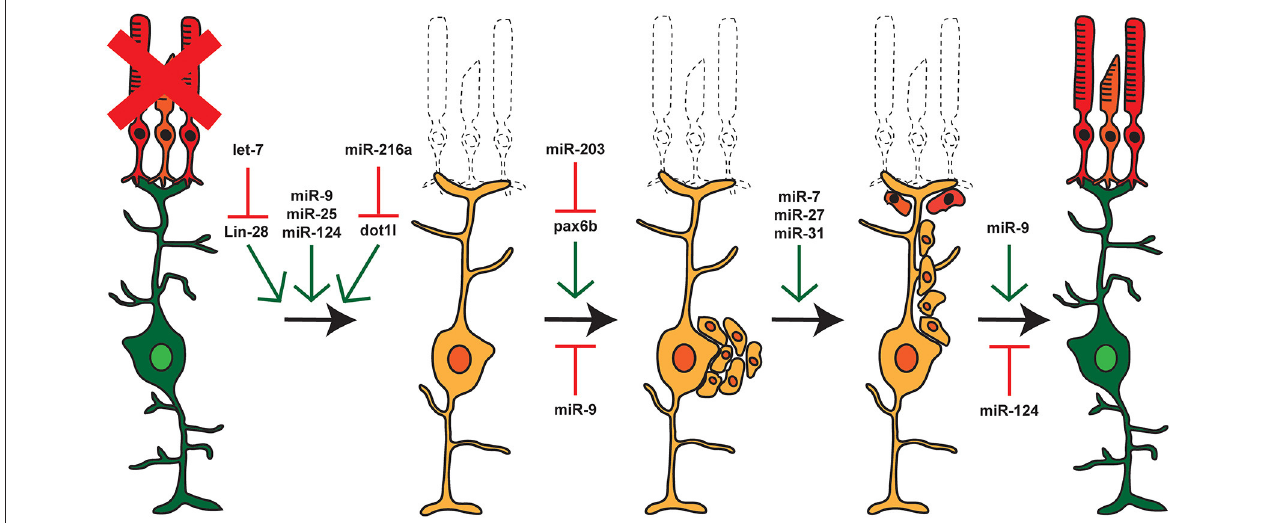
FIGURE 3 | miRNAs and Retina Regeneration. The adult zebrafish retina expresses ∼ 200 miRNAs but only a small subset of these miRNAs are differentially expressed during regeneration. RNAseq and other analyses after damage or during distinct stages of regeneration have identified miRNAs and select target mRNAs, as indicated. Green arrows represent miRNAs that are expressed or active at that given step, and red arrows represent miRNAs that are not expressed or